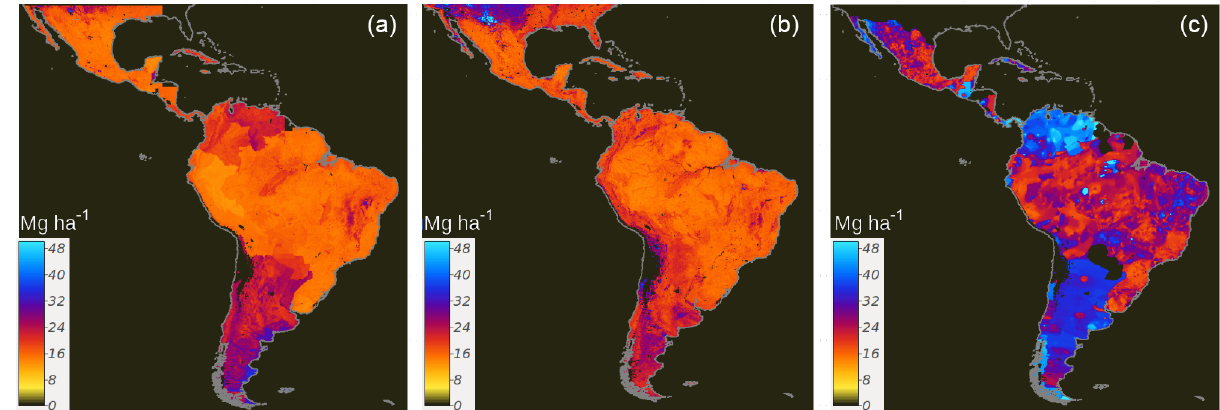
Figure 6. The full conditional response of residuals to the prediction factors on a country-specific basis (a) . The full conditional response of residuals to the SOC prediction factors in the regional (Latin America) model (b) . The trend of the approximated error of SOC estimates is derived from buffer distances and the random forest spatial framework (c)